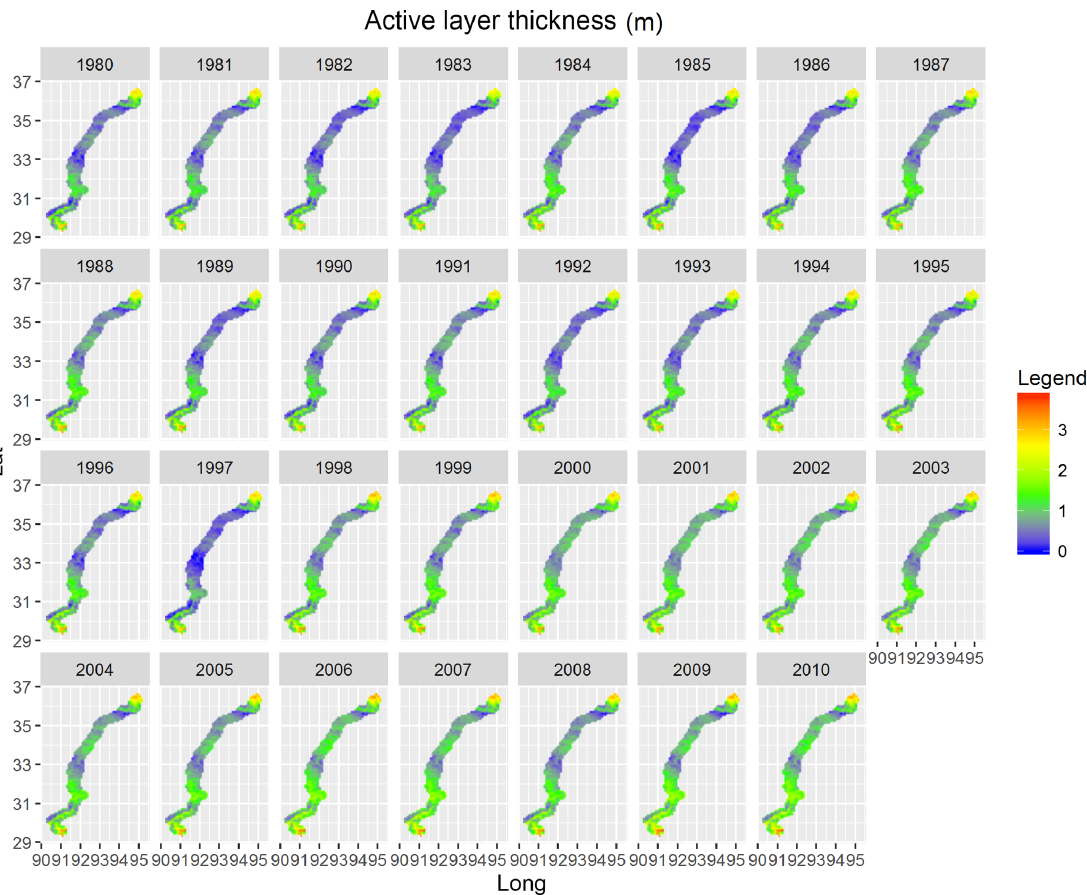
Figure 7. Regional visualization of ALT. Table 4. The statistical values of TTOP apply Com_ Stats_QTP for the stations where permafrost exists. Intercept: y -intercept; Slope: slope of regression line; R : Pearson’s correlation coefficient, R 2 : coefficient of determination; RMSE: root mean squared error; NRMSE: normalized RMSE; SD_S: the standard deviation of TTOP using the Stefan function; SD_K: the standard deviation of TTOP using